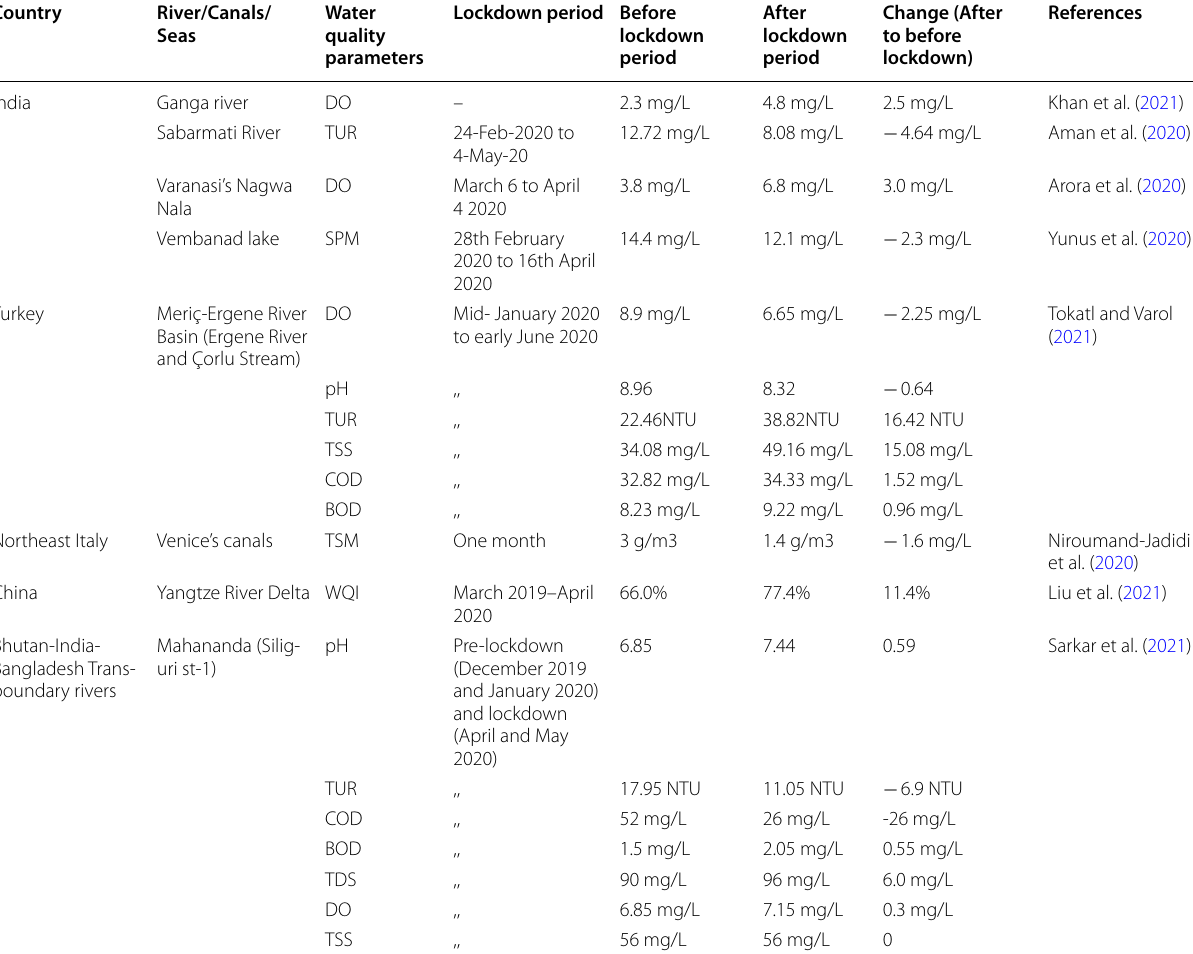
Table 1 Exemplary of the effect of COVID-19 lockdown on water quality parameters